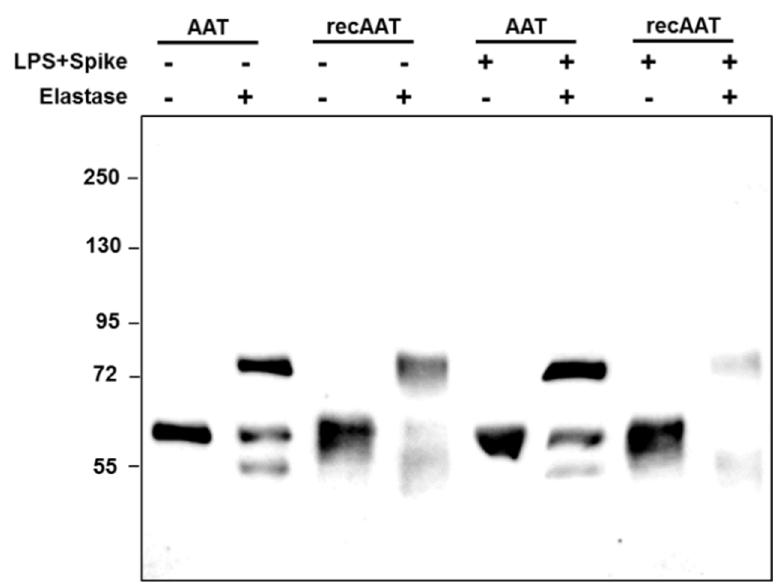
Figure 2. Analysis of AAT elastase complex formation in culture supernatants. PBMCs were incu- bated with 0.5 mg/mL plasma-derived AAT or recombinant AAT. Some cells were cultured with a combination of AAT proteins together with 10 ng/mL LPS and 12 µg/mL spike. After 6 h of